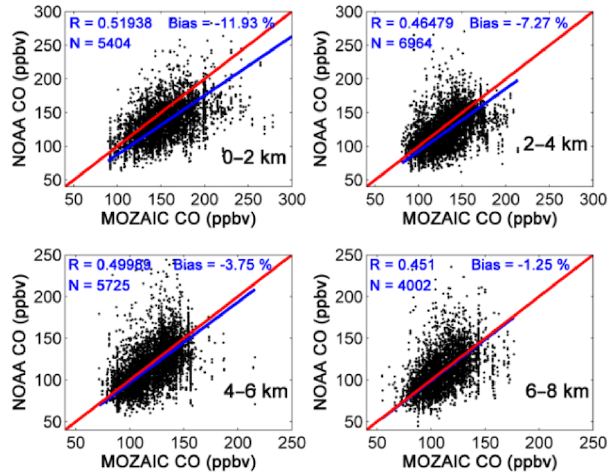
Figure 8. CO mixing ratio comparison between trajectory-derived and NOAA flask data for the period from 2001 to 2012, for four altitude ranges. Bias is calculated as the mean of the differences in percent, [2(NOAA-Clim) / (Clim + NOAA)], of all data points. The blue line is the line of best fit, the red line is the 1 : 1 line, N is number of data pairs, and R is the correlation coefficient. Monthly trajectory-mapped CO data are used for the comparison or seasonal mean values if the monthly mean value for a particular grid cell is not